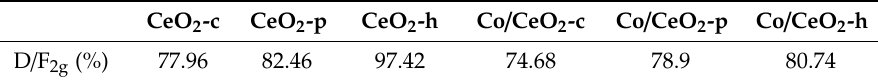
Figure 8. Raman spectra of CeO 2 supports and 4% Co / CeO 2 catalysts. Table 2. Relative population of oxygen